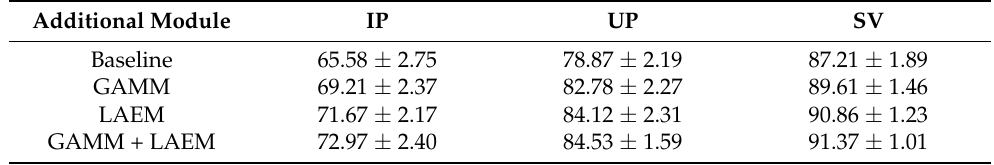
Table 4. OAs obtained by GDAFSL with various feature extraction modules on three target datasets. Additional Module